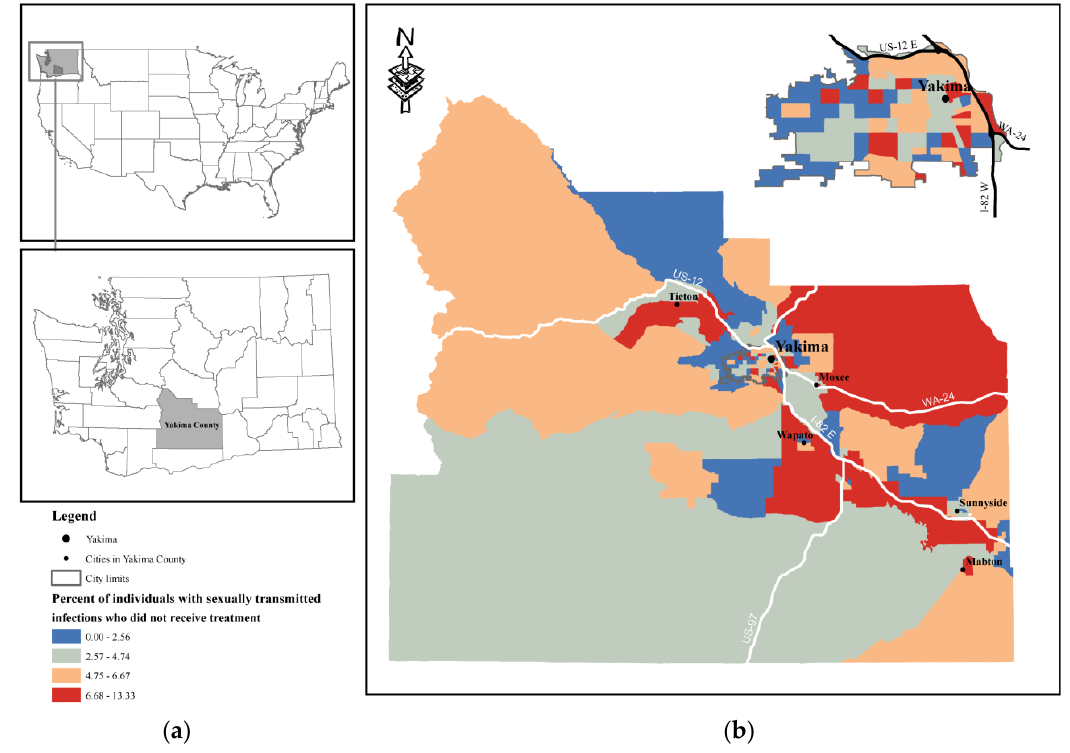
Figure 1. Study area location in the United States and Washington State ( a ) and STI rates in block groups in Yakima County and Yakima City ( b ). Table 1. Characteristics of patients diagnosed with sexually transmitted infections in Yakima County, Washington between 2007 and 2018, overall and stratified by treatment status (n = 16,075).